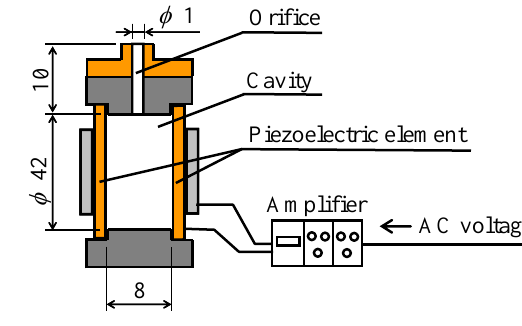
Fig. 1 Schematic of experimental channel and MFS position.